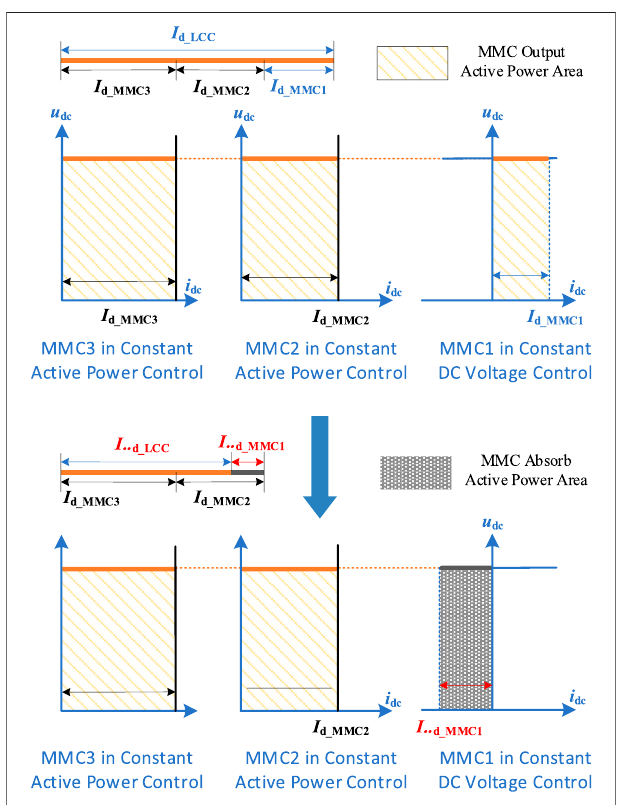
FIGURE 7 | The active power distribution characteristic when fault happens at inverter side.